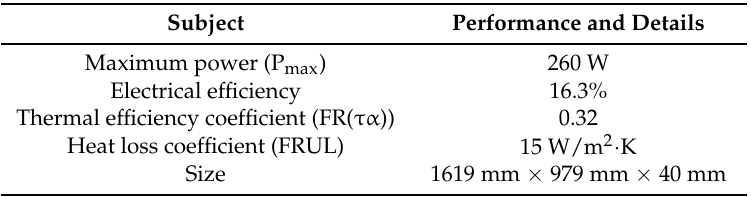
Table 1. Air ‐ type PVT collector performance and details. Table 1. Air-type PVT collector performance and details.